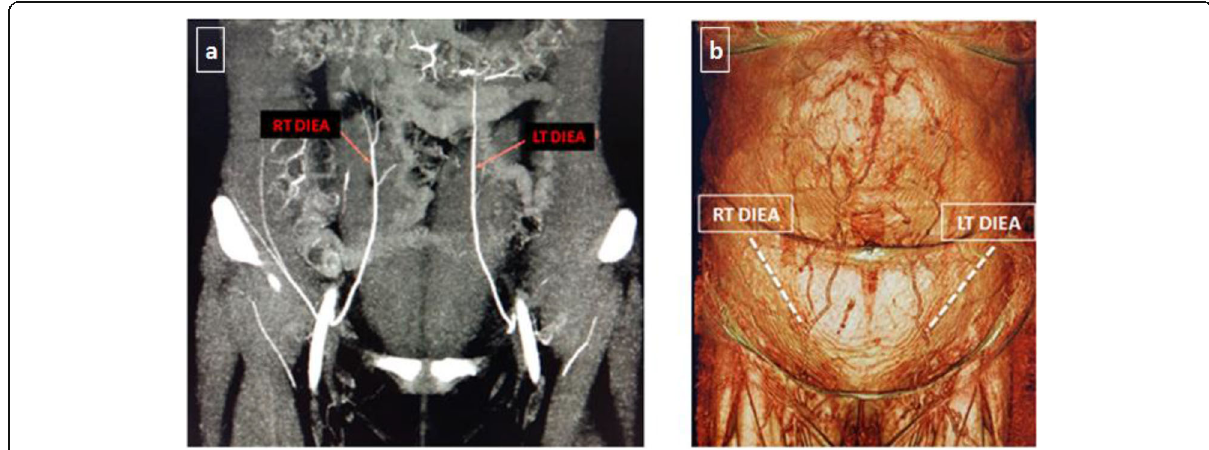
Fig. 2 Coronal image of the anterior abdominal wall showing maximum intensity projection (MIP) ( a ) and volume rendering (VR) reformat ( b ) of both deep inferior epigastric arteries